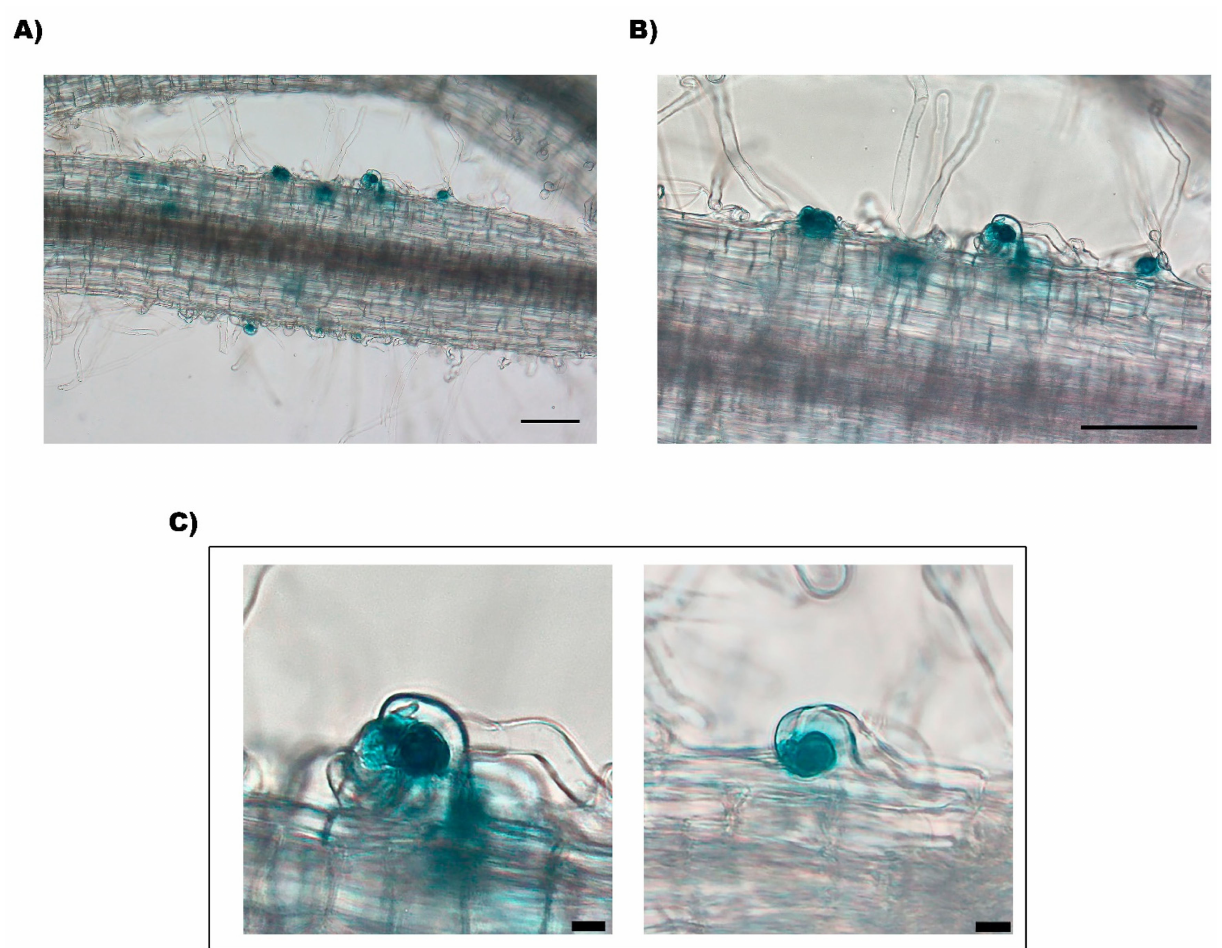
Figure 5. Infection phenotype of nnod (2353) mutant inoculated with R. etli CE3/pGUS: formation of infection chambers. Microscopic observations of the infection chamber, or microcolony, formed in curled root hair of inoculated nnod (2353) roots, visualized after GUS staining. ( A , B ) Bar = 100 µ m. ( C ) Bar = 10 µ